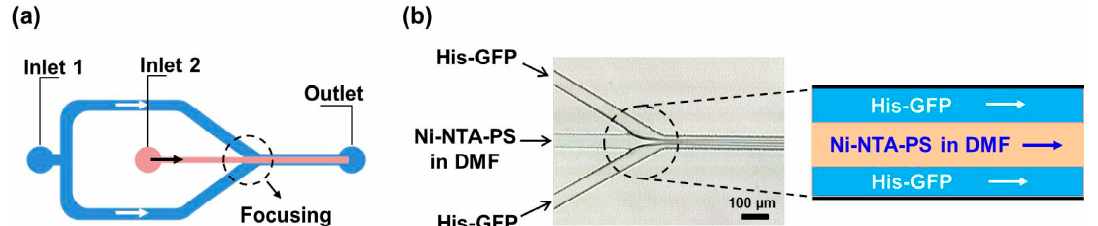
Figure 2. Schematic of the flow-focusing channel: ( a ) design of the flow-focusing channel; ( b ) the three-layered lamination flow. His-GFP: histidine tagged GFP; Ni-NTA-PS: nitrilotriacetic acid end-functionalized polystyrene; DMF: dimethylformamide.